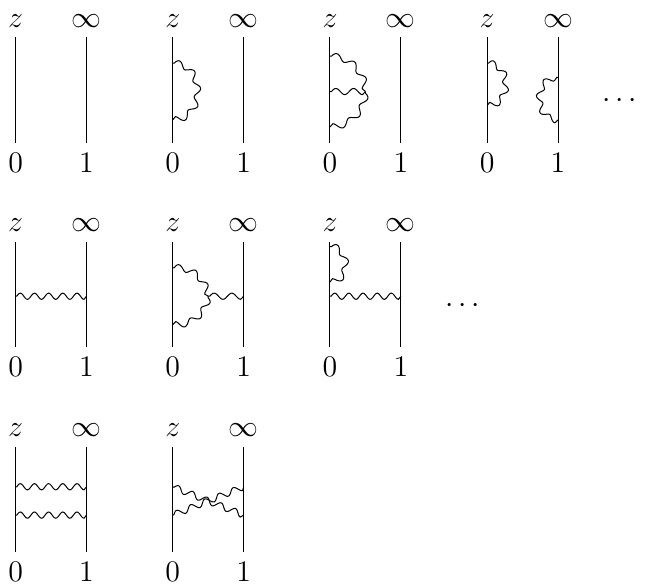
Figure 2 . Several representative contributions to the identity four point block from the network of open Wilson lines up to the 1 =c 2 order. The top diagrams represent the contributions of the self-energy type. The middle diagrams represent the contribution with the exchange of energy momentum tensor and its 1 =c corrections. The bottom diagrams represent the contributions with the exchange of two spin s currents with s = 2 or s = 3 =